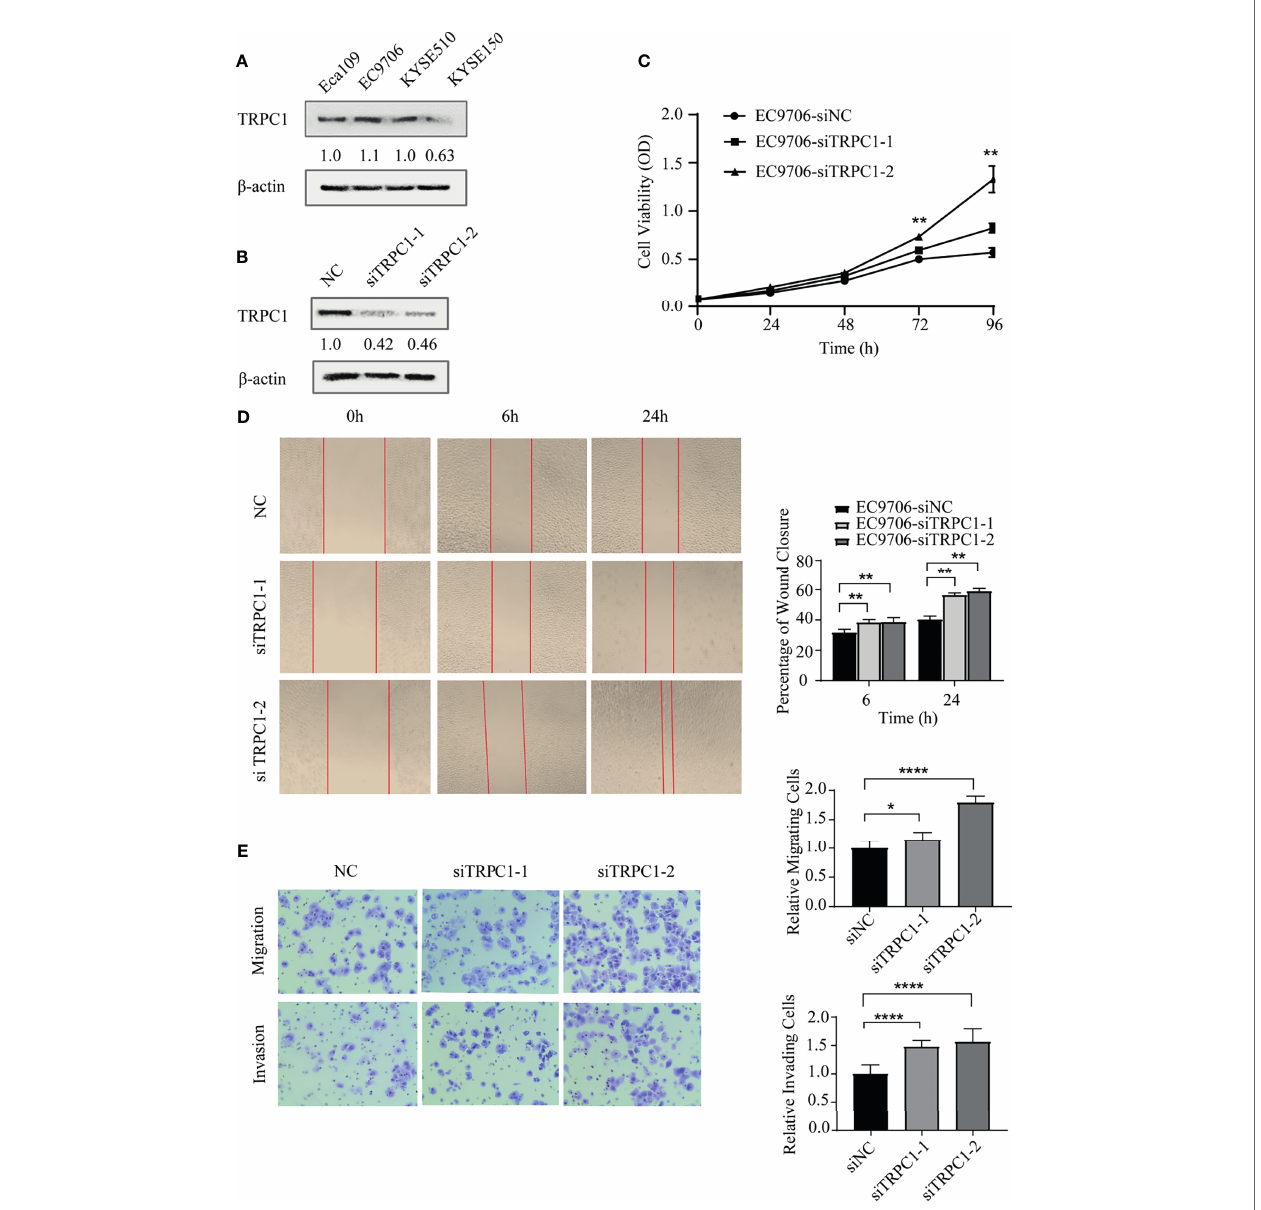
FIGURE 3 | Knockdown of TRPC1 by transfection with siRNA promoted the proliferation, wound healing, migration, and invasion abilities of EC9706 cells. (A) Western blotting showed TRPC1 expression in four esophageal squamous carcinoma cell lines: Eca109, EC9706, KYSE510, and KYSE150. (B) Representative western blot showing the effect of siRNA directed against TRPC1 on the level of TRPC1 protein in EC9706. (C) Analysis of proliferation of cells transfected with siTRPC1 by CCK-8 assay. Cell proliferation was measured 24, 48, 72, and 96h post-transfection. After treatment with siTRPC1, the viability of EC9706 cells was signi fi cantly increased. (D) Cellular wound healing after knockdown of TRPC1 in EC9706 cells (magni fi cation: 100×). The rate of wound healing of EC9706- siTRPC1-1 or EC9706-siTRPC1-2 cells was signi fi cantly higher than that of EC9706-siNC cells (P<0.01). (E) Cell migration and invasion after knockdown of TRPC1 (magni fi cation: 100×). The cells of the silenced expression group (EC9706-siTRPC1-1 or EC9706-siTRPC1-2) had higher migration and invasion abilities than those of the control group (EC9706-siNC), (P<0.05). NC represented as negative control. *P < 0.05, **P < 0.01, ****P <